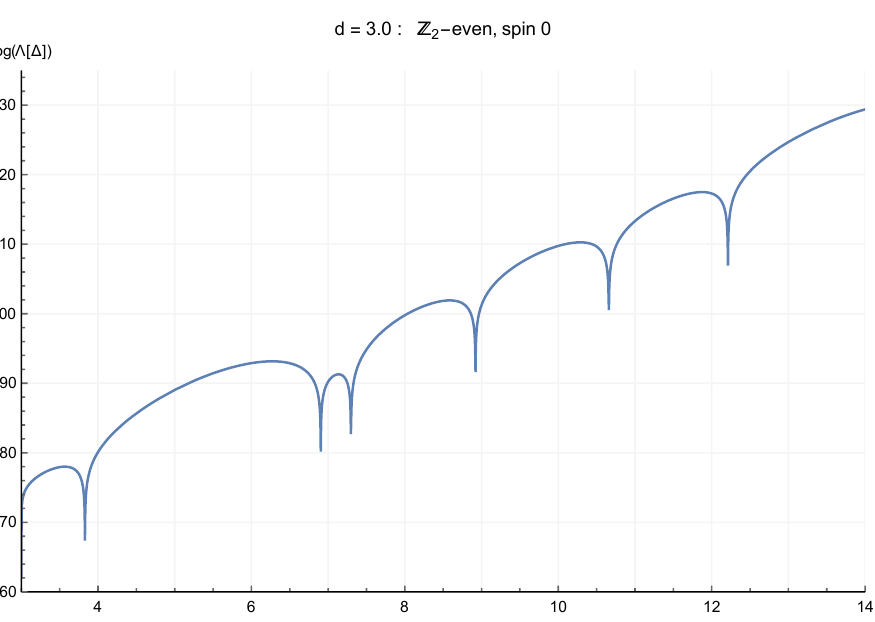
Figure 21 . Extremal functional Λ(∆) for Z 2 -even scalars of dimensions ∆ at d = 3 . 0 dimensions.